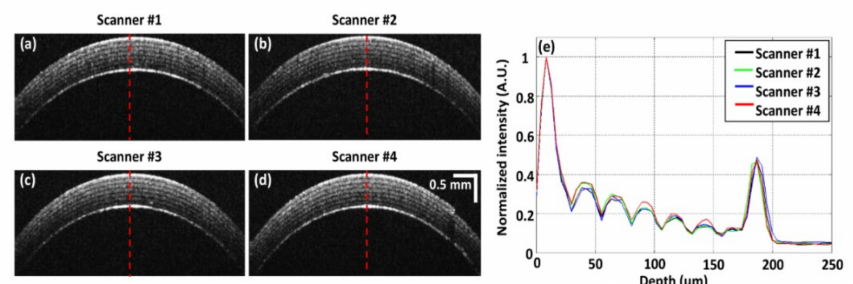
Figure 4. Quantitative performance assessment of each sample arm in quad-scanner (QS)-OCT; ( a – d ) are B-scan images of a Scotch tape roll obtained by sequentially switching the scanner; ( e ) demon- strates the A-scan profiling results of images ( a – d ) centered on the red-dashed line to quantitatively analyze